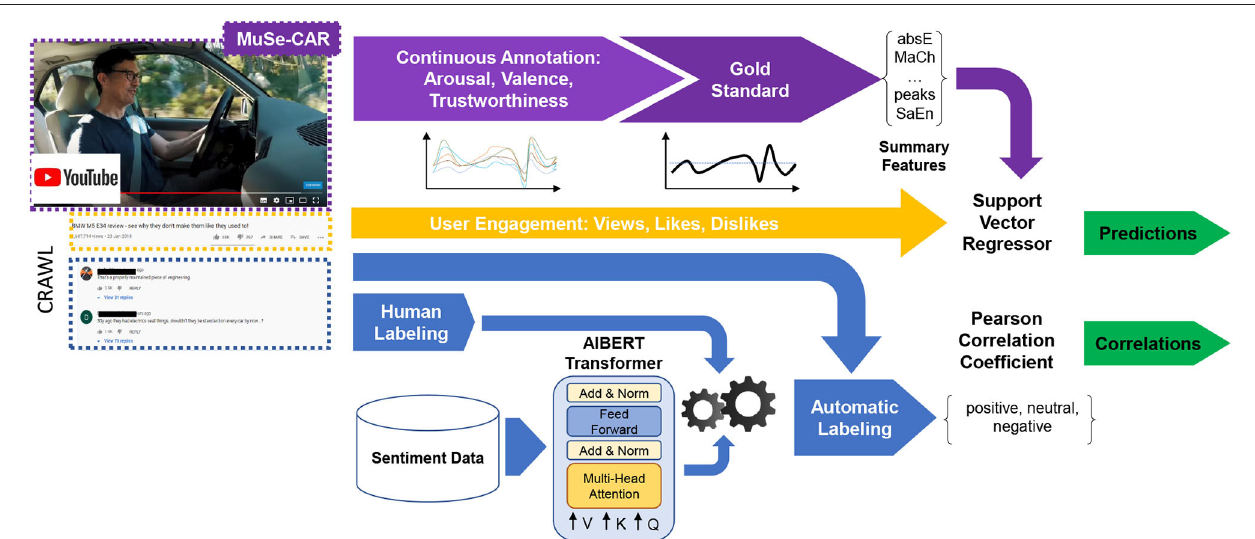
FIGURE 2 | A comprehensive overview of the approach, as explained in Section 4. Statistics derived from continuous emotion and trustworthiness (purple), automatic sentiment labeling of YouTube comments (blue), and user engagement data (orange) are preprocessed to investigate correlations and predict engagement from features. The development of our signal feature extraction as a cornerstone of our analysis is described in detail in Section 4.1. With its help, we aim to uncover relationships to engagement data (cf.Section 4.3) and the sentiment of the comments predicted by our trained network (cf.Section 4.2). They also serve as input to our regression experiments to predict user engagement (cf.Section 4.5).